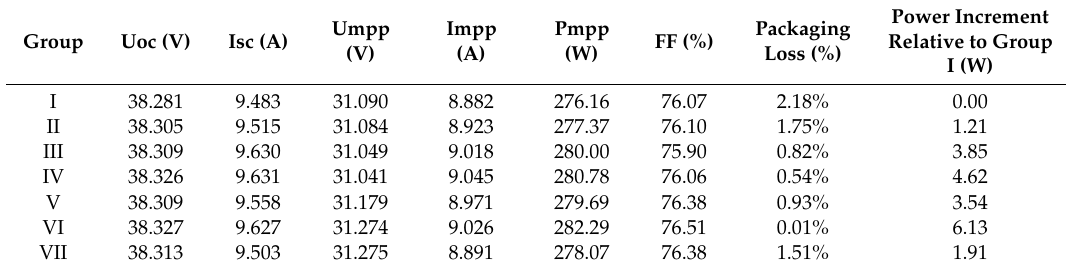
Table 7. The electrical performance results of the seven